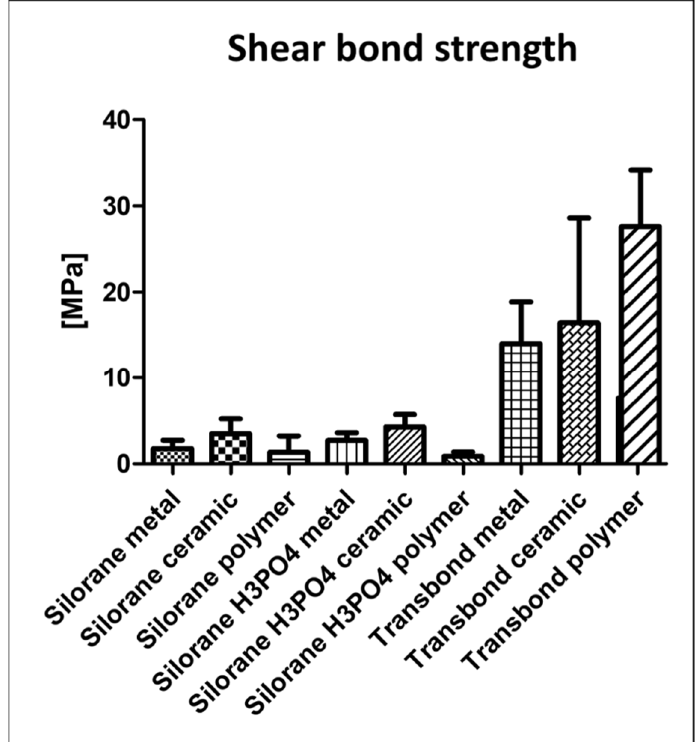
Figure 1. Mean shear bond strength and standard deviations. Significant differences ( p ≤ 0.05) were found between the Filtek Silorane and the Transbond XT groups.